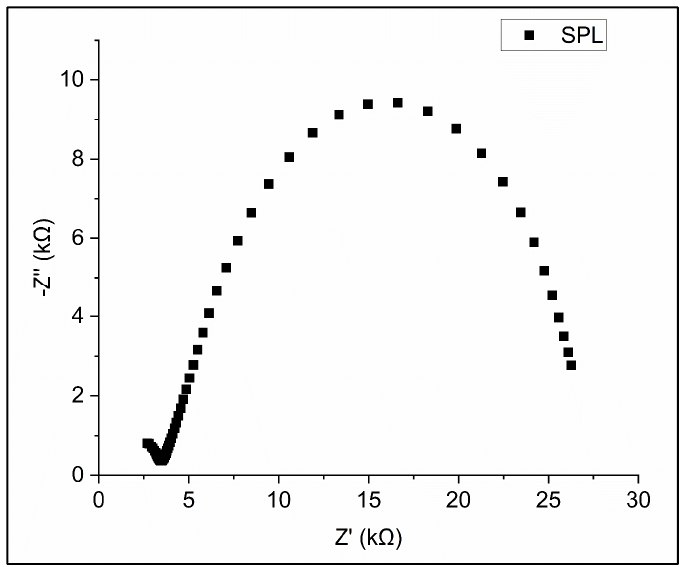
Figure 2. Nyquist plots of the S-CoS@CNT- PEO-LiTFSI-LCO/PEO-LiTFSI-LCO/Li metal.